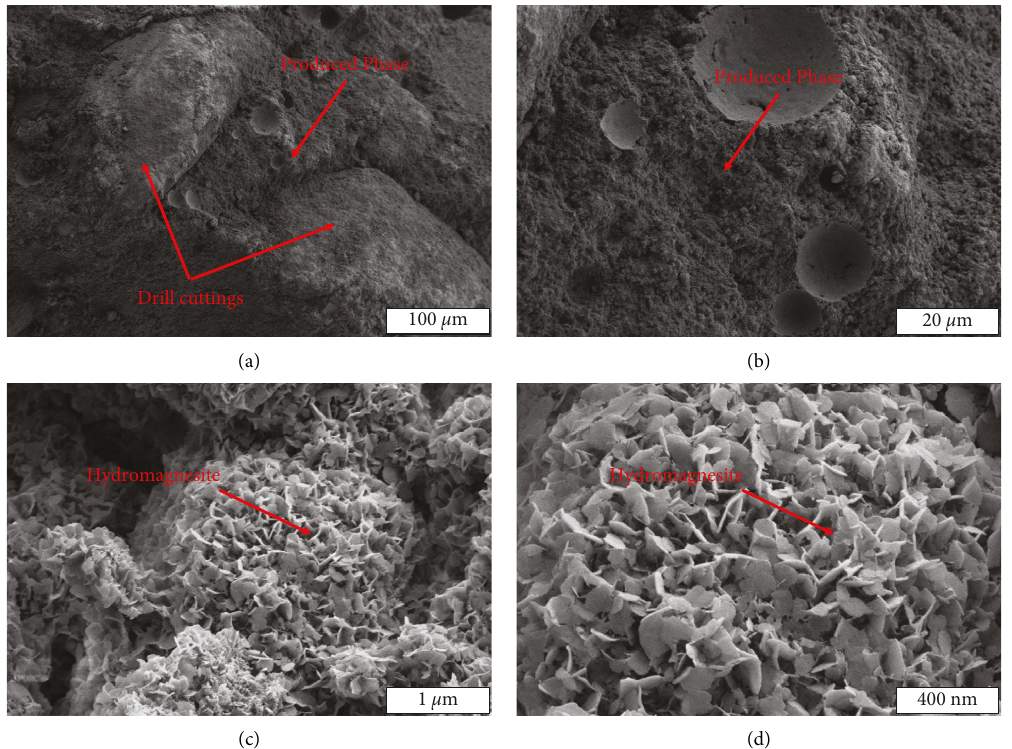
Figure 8: SEM images of bio-carbonated RMC-based WDC samples after 28 days of curing.